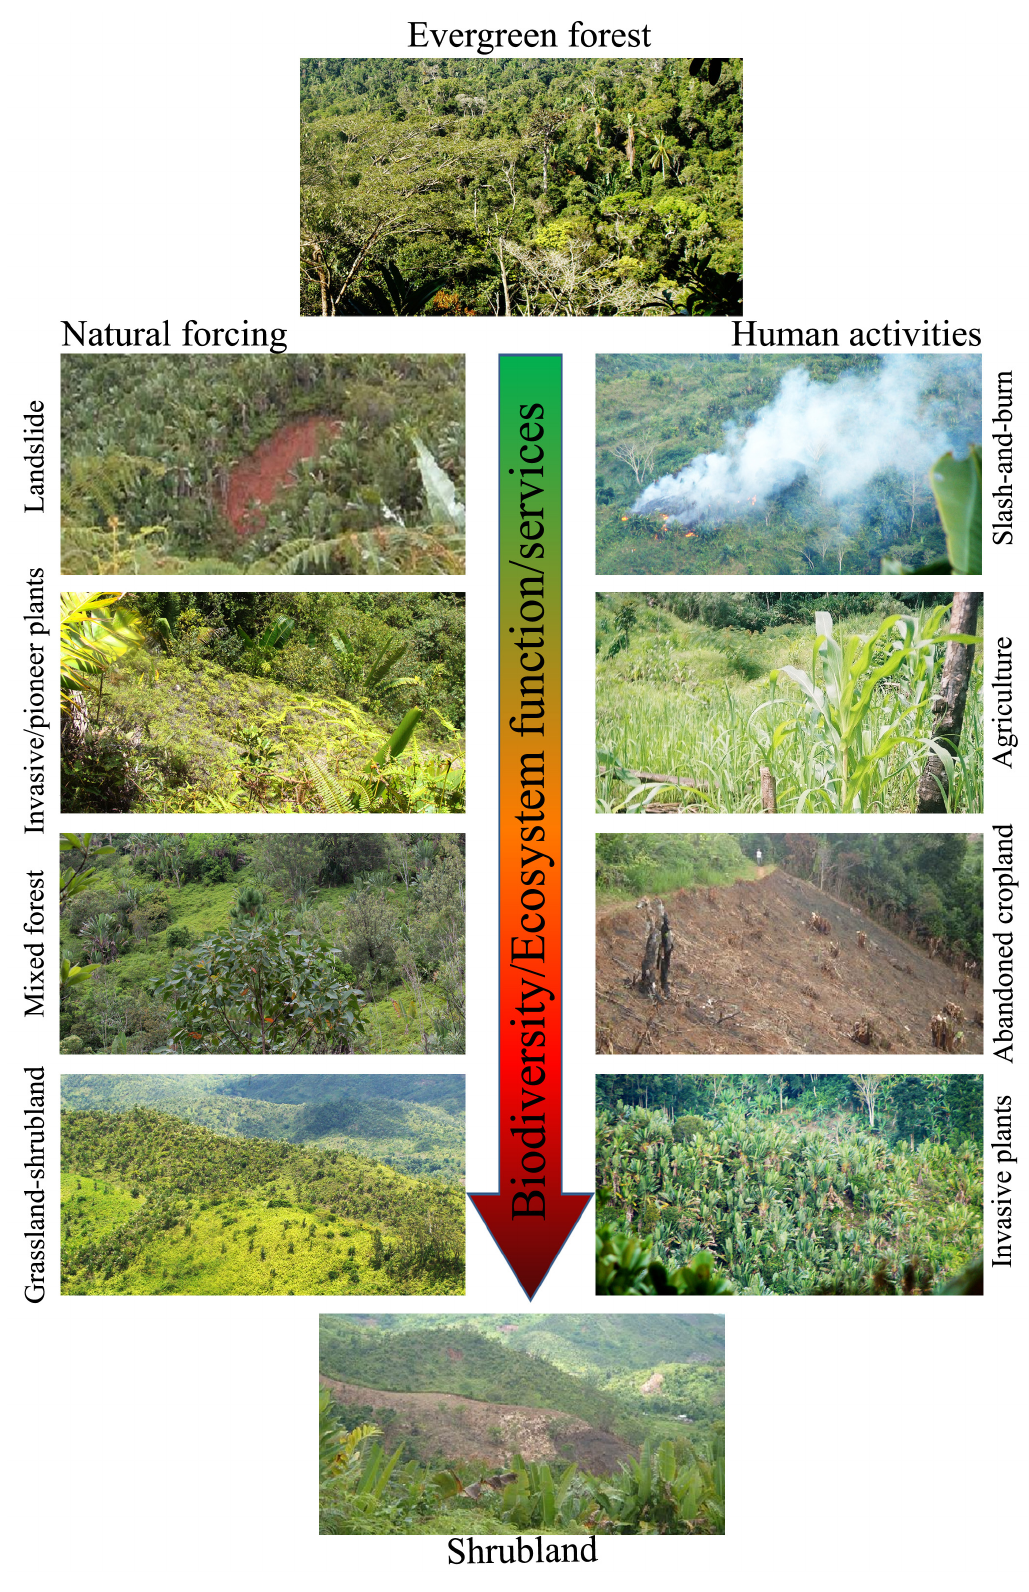
Figure 11. A conceptual framework of ecosystem degradation in the study area showing transition pathways due to natural forces and human activities (adapted from [41]). Invasive plants occupy areas cleared from landslides and abandoned croplands. Evergreen forests are converted to mixed forest, agricultural lands, grassland and shrubland, and/or eventually to degraded